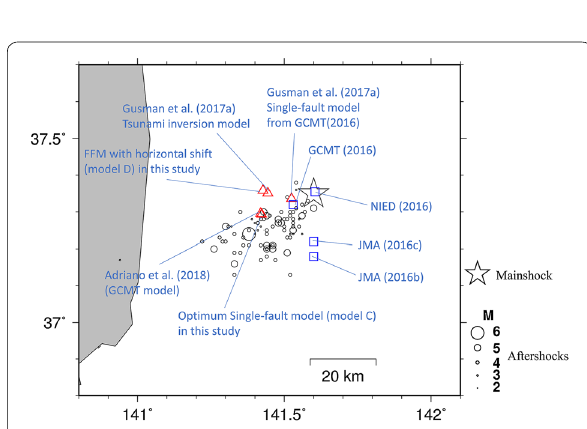
Fig. 9 Comparison of horizontal locations. Red triangles show the horizontal locations of the negative peak of the initial sea surface displacement for each model. The horizontal locations were measured by the figure of Gusman et al. (2017a), Adriano et al. (2018) and this study. The centroid locations of each institution are also shown with blue